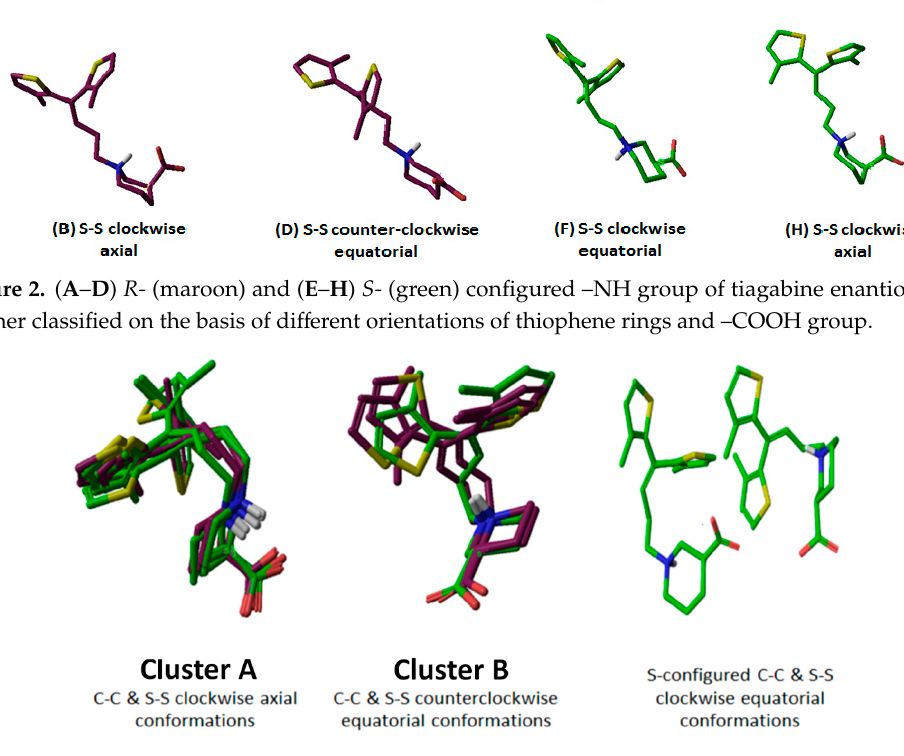
Figure 3. Clustering of R - and S -configured tiagabine enantiomers. Superimposition showed a similar orientation pattern in cluster A and B unconstraint ; however, two S -configured C–C/S–S clockwise equatorial unconstraint tiagabine enantiomers with different conformation patterns in hGAT1 are also presented.